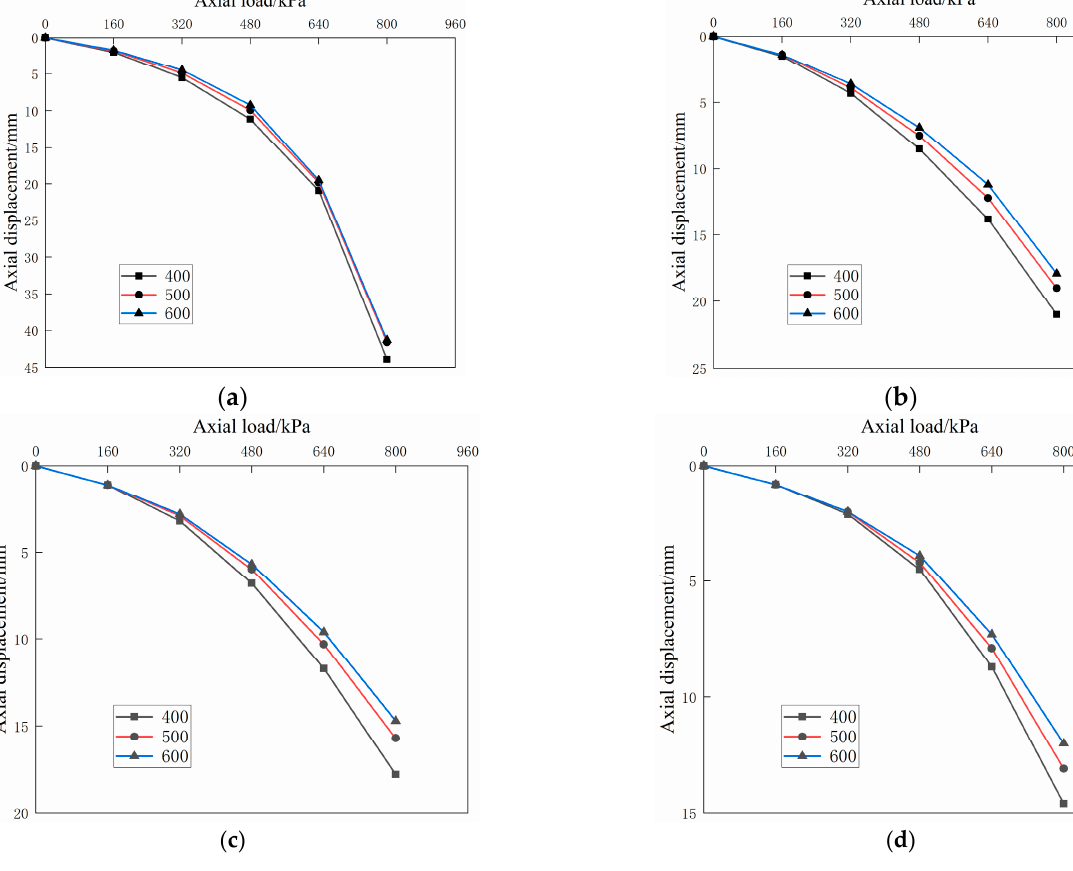
Figure 19. Q-s curve of stiffened core: ( a ) pile spacing is 2d1; ( b ) pile spacing is 3d1; ( c ) pile spacing is 4d1; ( d ) pile spacing is 5d1.